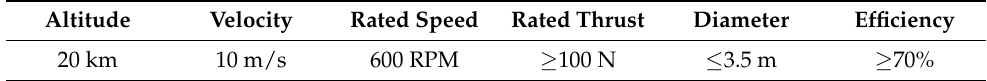
Table 1. The design index of